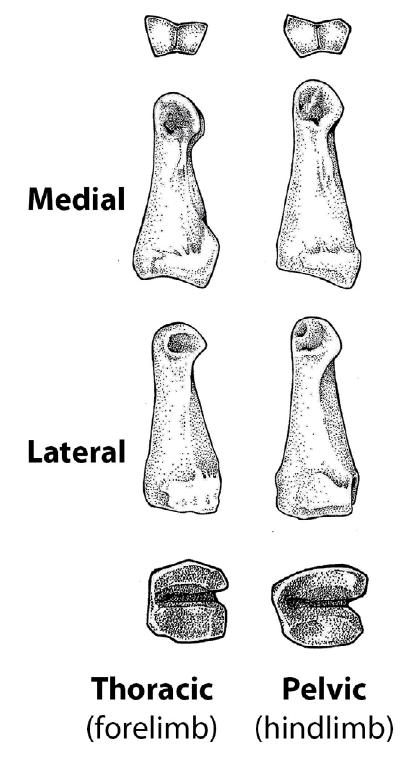
Figure 3. PI (Reverse anatomical position). Illustra- tion by author.